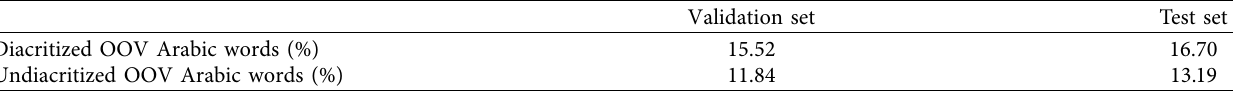
Table 3: Percentage of out of vocabulary (OOV) in validation and test sets compared to the training